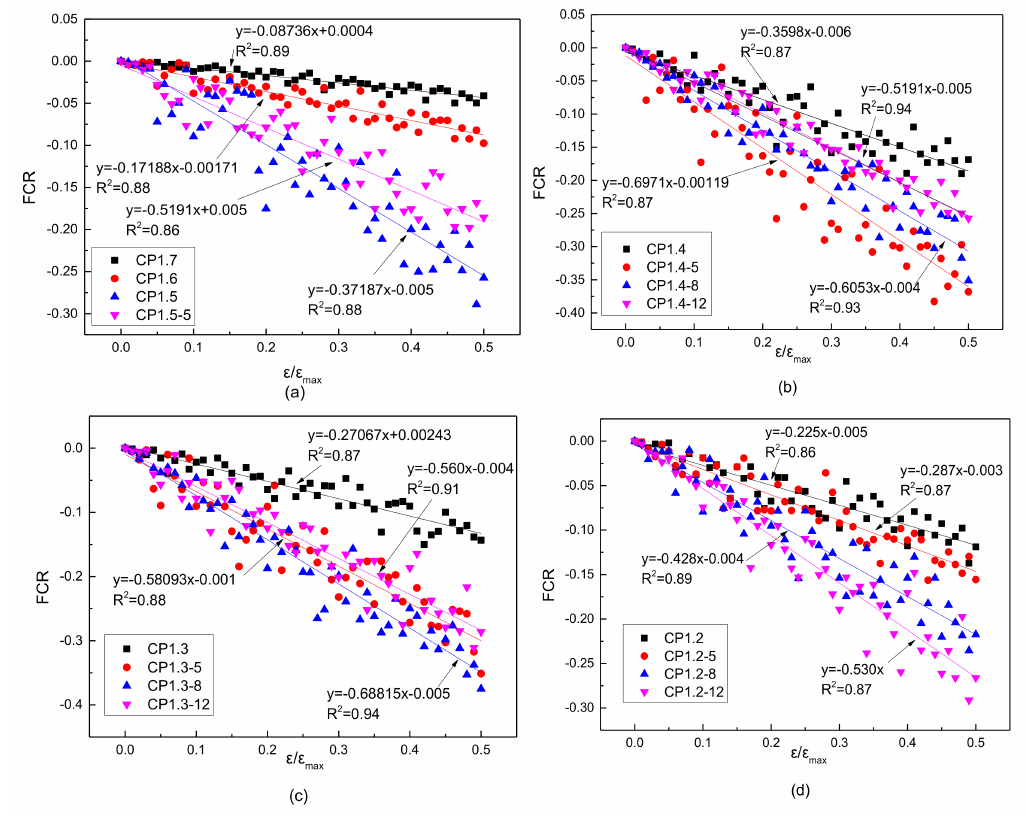
Figure 5. Sensitivity fitting curve for CNFPUC hexahedron specimen with different ratio of polymer and silica fume. ( a ) Sensitivity fitting curve of CP1.7, CP1.6, CP1.5 and CP1.5-5; ( b ) Sensitivity fitting curve of CP1.4, CP1.4-5, CP1.4-8 and CP1.4-12; ( c ) Sensitivity fitting curve of CP1.3, CP1.3-5, CP1.3-8 and CP1.3-12; ( d ) Sensitivity fitting curve of CP1.2, CP1.2-5, CP1.2-8 and CP1.2-12.